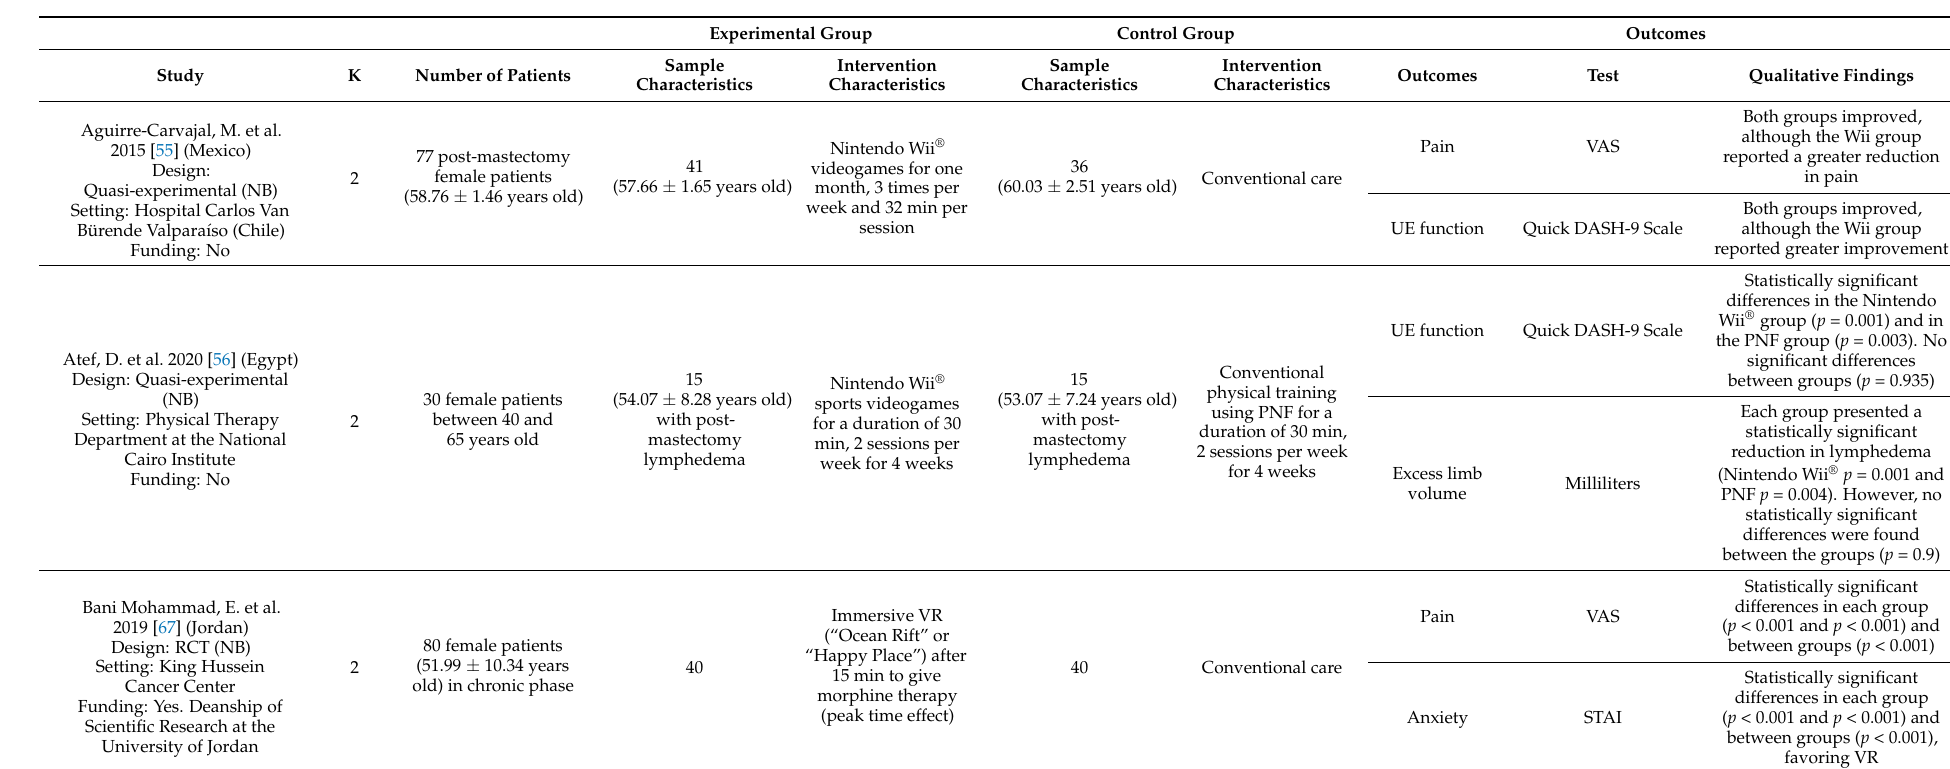
Table 2. Main characteristics of the studies included and qualitative individual